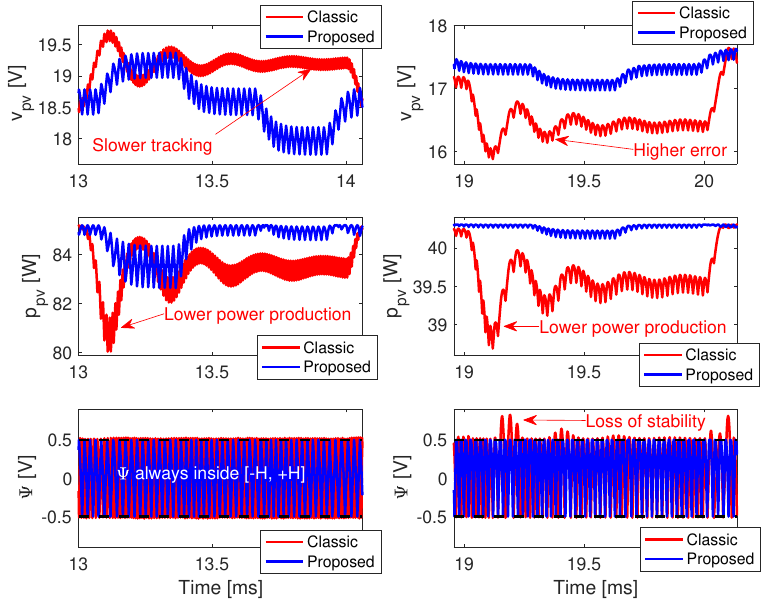
Figure 17. Detail of the comparison between the classical and proposed solutions at 1000 W/m 2 ( left ) and 500 W/m 2 ( right